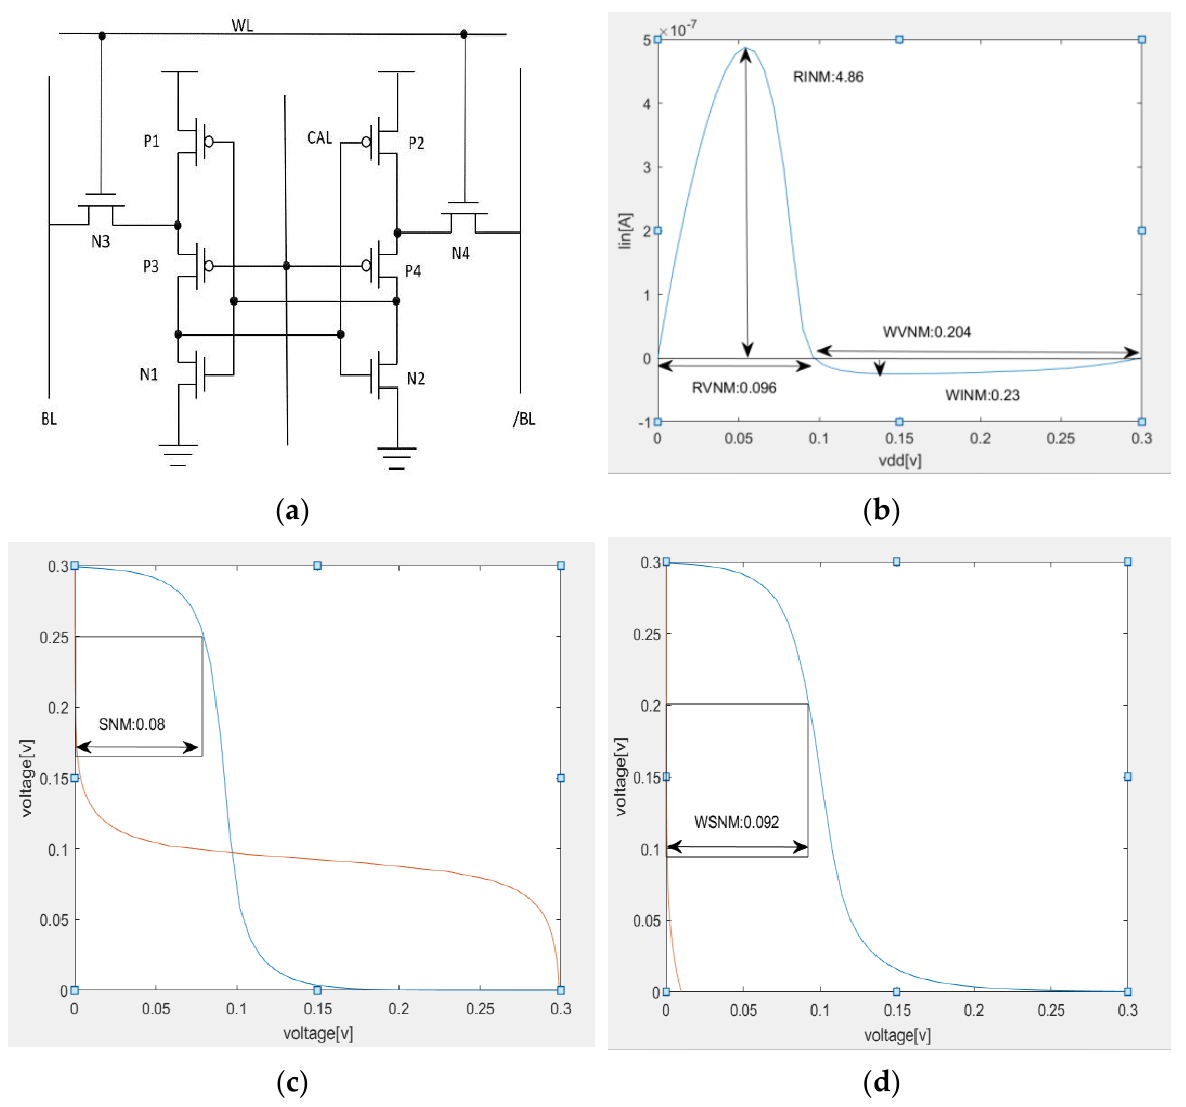
Figure 10. ( a ) 8T unit schematic; ( b ) stability based on leakage current; ( c ) read static stability; and ( d ) write static stability.